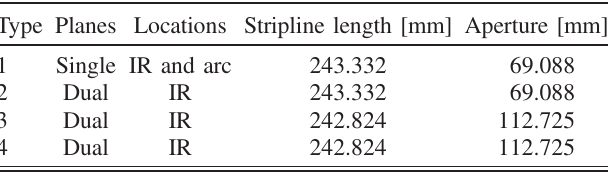
TABLE I. RHIC BPM mechanical